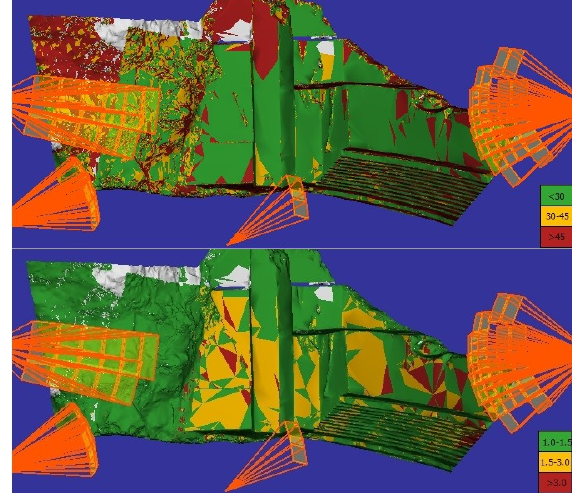
Figure 3. 3D model textured with quality maps: viewing angle (top), scale (bottom).